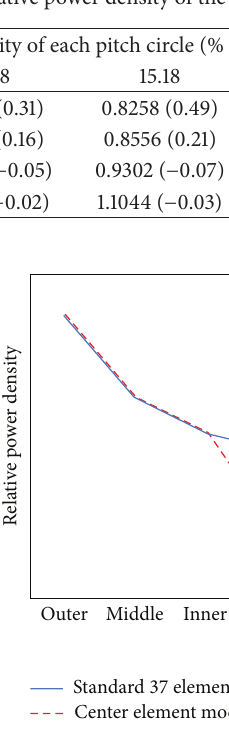
Figure 6: Relative power densities (RFD) of a 37S fuel bundle and center element